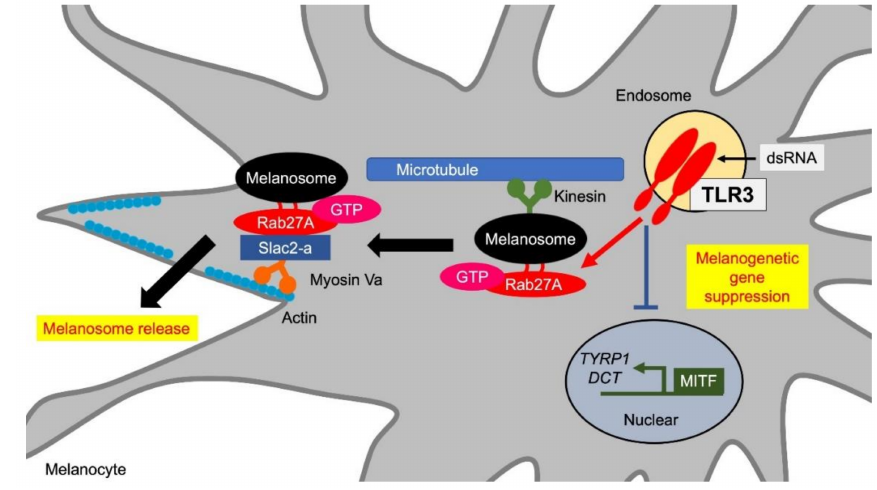
Figure 3. TLR3 promotes melanosome transfer. TLR3 stimulation reduces de novo melanin synthesis by suppressing the expression of MITF, TYRP1, and DCT. On the other hand, TLR3 stimulation promotes extracellular release of melanosomes through Rab27A induction. Rab27A on melanosomes binds to the actin-dependent motor protein myosin Va via Slac2-a and promotes actin transport toward the cell periphery near the cell membrane by forming a tripartite complex. Abbreviations: TLR: toll-like receptor; MITF: microphthalmia-associated transcription factor; TYRP1: tyrosinase-related protein 1; DCT: dopachrome